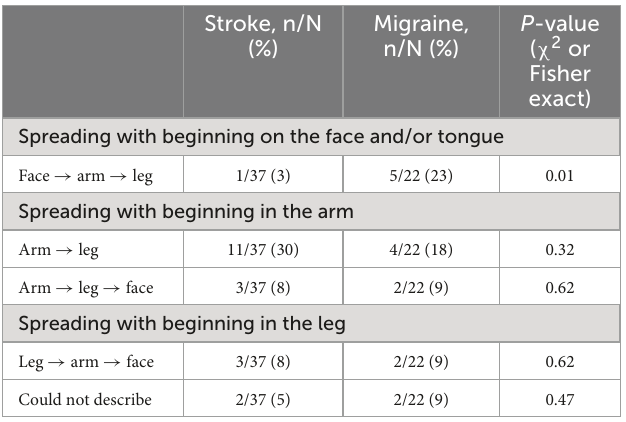
TABLE 6 Patterns of spreading of motor symptoms reported by both patients with ischemic stroke and migraine aura.